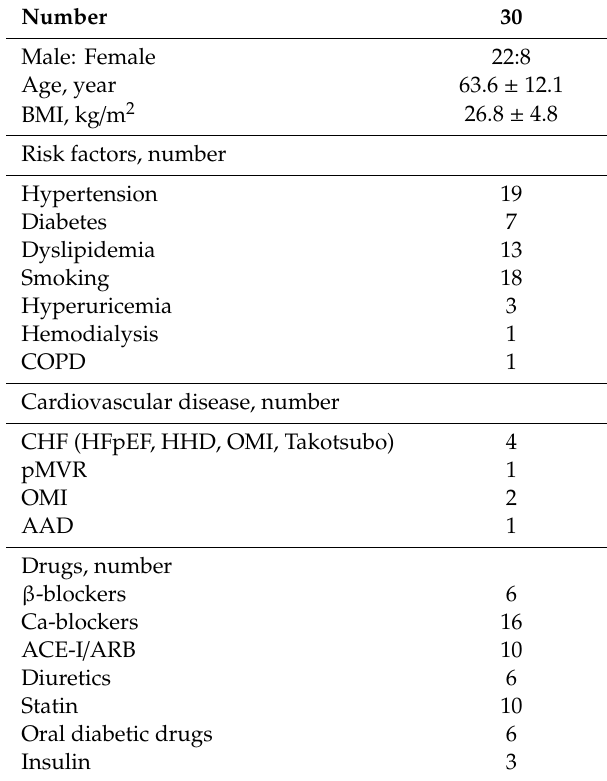
Table 1. Patient